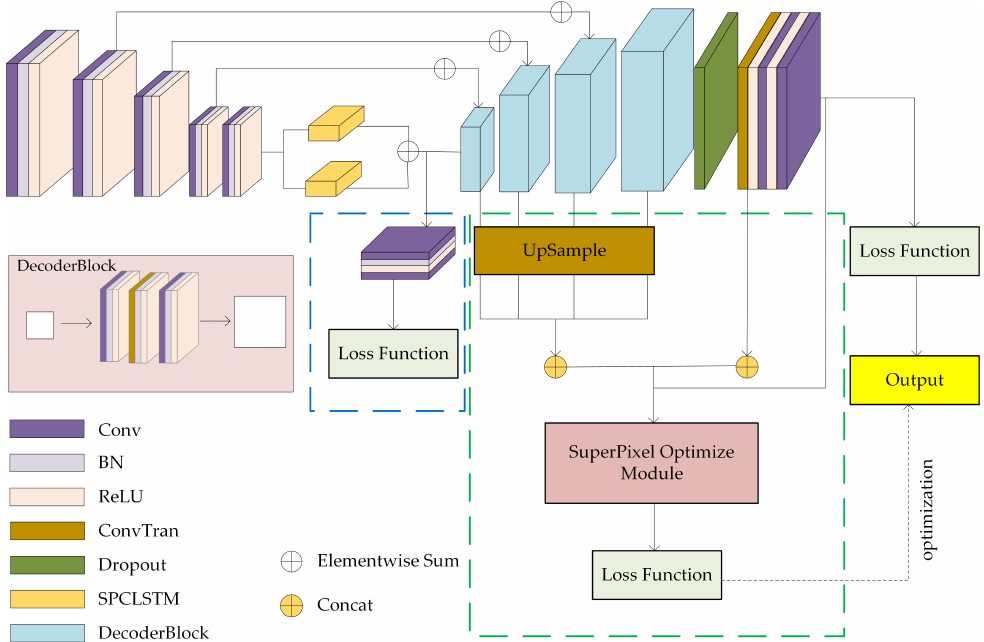
Figure 2. Architecture of our proposed network. The blue box in the figure represents the multitask branch network, and the green box represents the superpixel branch network. In the figure, Conv represents convolution operation with kernel size equal to 3 × 3, BN represents batch normalization, and ReLU means rectified linear unit. ConvTran represents the transpose convolution used to expand the feature size. Dropout is a special operation to prevent overfitting in convolutional neural networks. Elementwise Sum means the addition of two matrix corresponding position elements, and Concat means stacking the matrix in a certain